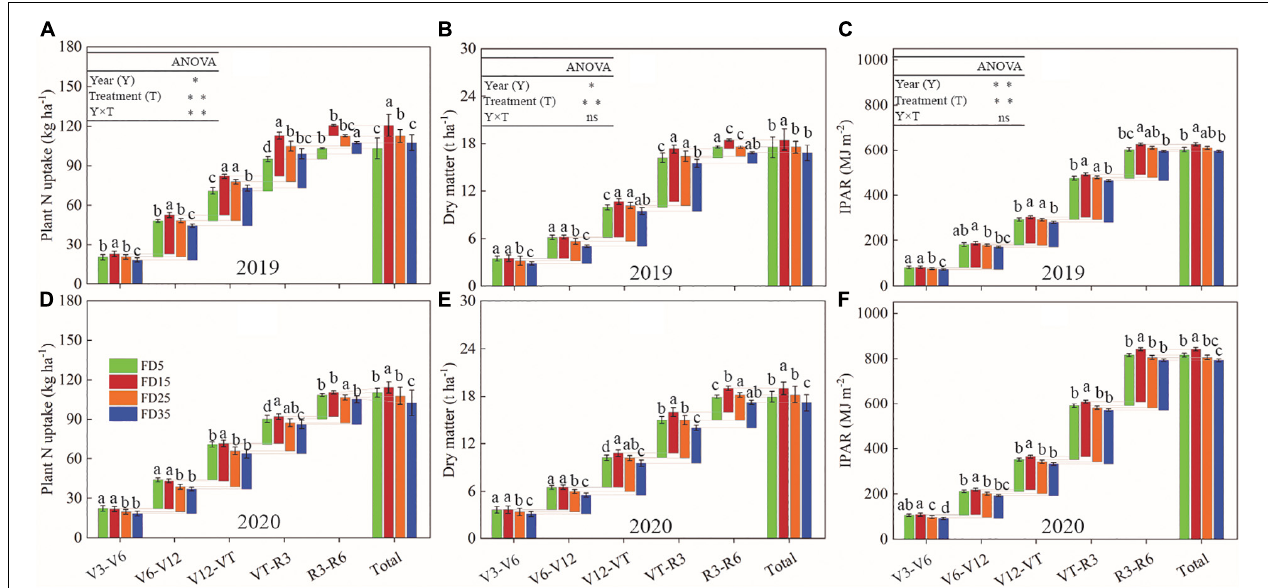
FIGURE 7 | Effects of fertilizer application depths on plant nitrogen (N) uptake (A,D) , dry matter (B,E) and intercepted photosynthetically active radiation (IPAR, C,F ) of summer maize in 2019 and 2020. FD5, fertilizer application at a depth of 5 cm; FD15, fertilizer application at a depth of 15 cm; FD25, fertilizer application at a depth of 25 cm; and FD35, fertilizer application at a depth of 35 cm. The vertical bars stand for standard deviation. The different lowercase letters indicate a significant difference among the treatments at P < 0.05 using the LSD method. ns, no significant difference; ∗ , significant at P < 0.05; ∗∗ , significant at P < 0.01.